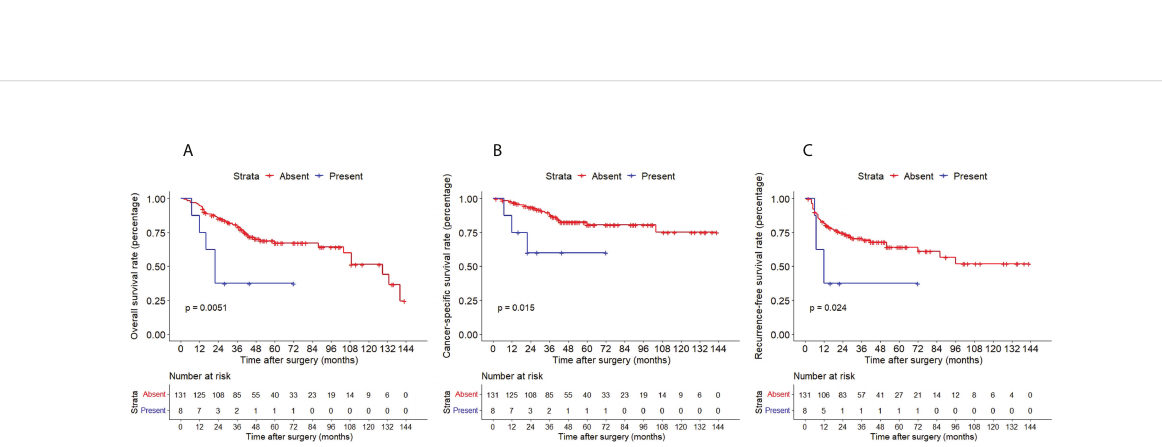
FIGURE 6 Kaplan – Meier curves for OS (A) , CSS (B) and RFS (C) of patients with UTUC according to previous history of bladder cancer. OS, overall survival; CSS, cancer-speci fi c survival; UTUC, upper tract urothelial carcinoma; IVR, intravesical